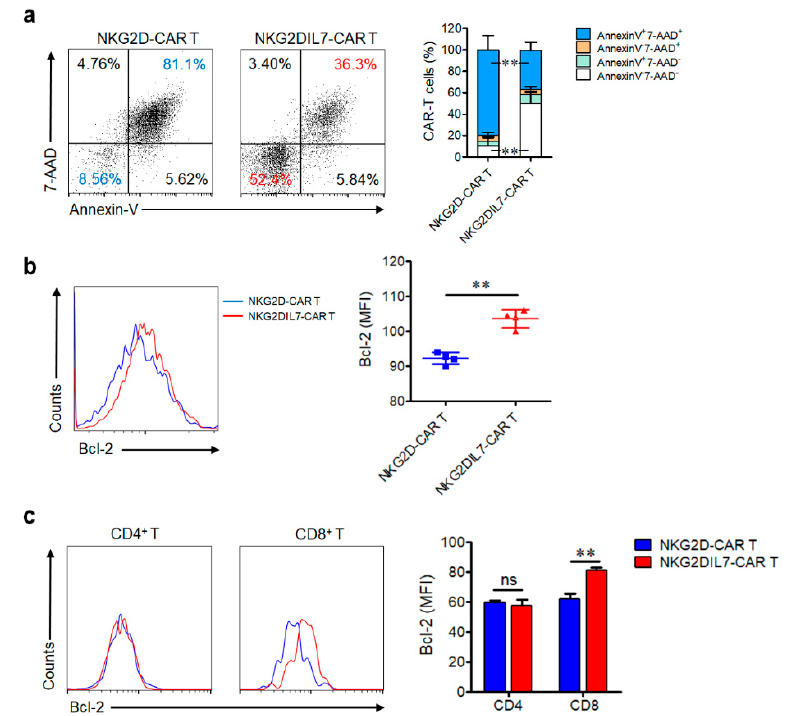
Figure 3. Co-expression of IL-7 reduces the apoptosis of NKG2D-CAR T cells. ( a ) After NKG2D-CAR and NKG2DIL7-CAR T cells were cocultured with PC-3 tumor cells for 7 days, the cells were stained with Annexin-V / 7-AAD and the apoptosis was detected by FACS. The statistical analysis was shown in the right panel. ( b ) Flow cytometric analysis of Bcl-2 protein expression in CAR T cells 7 days after tumor cell stimulation. ( c ) The Bcl-2 expression in CD4 + and CD8 + CAR T cells was detected by FACS 7 days after tumor cell stimulation. ** p < 0.01. Data are representative of 4 donors and have been gated on NKG2D + T cells.